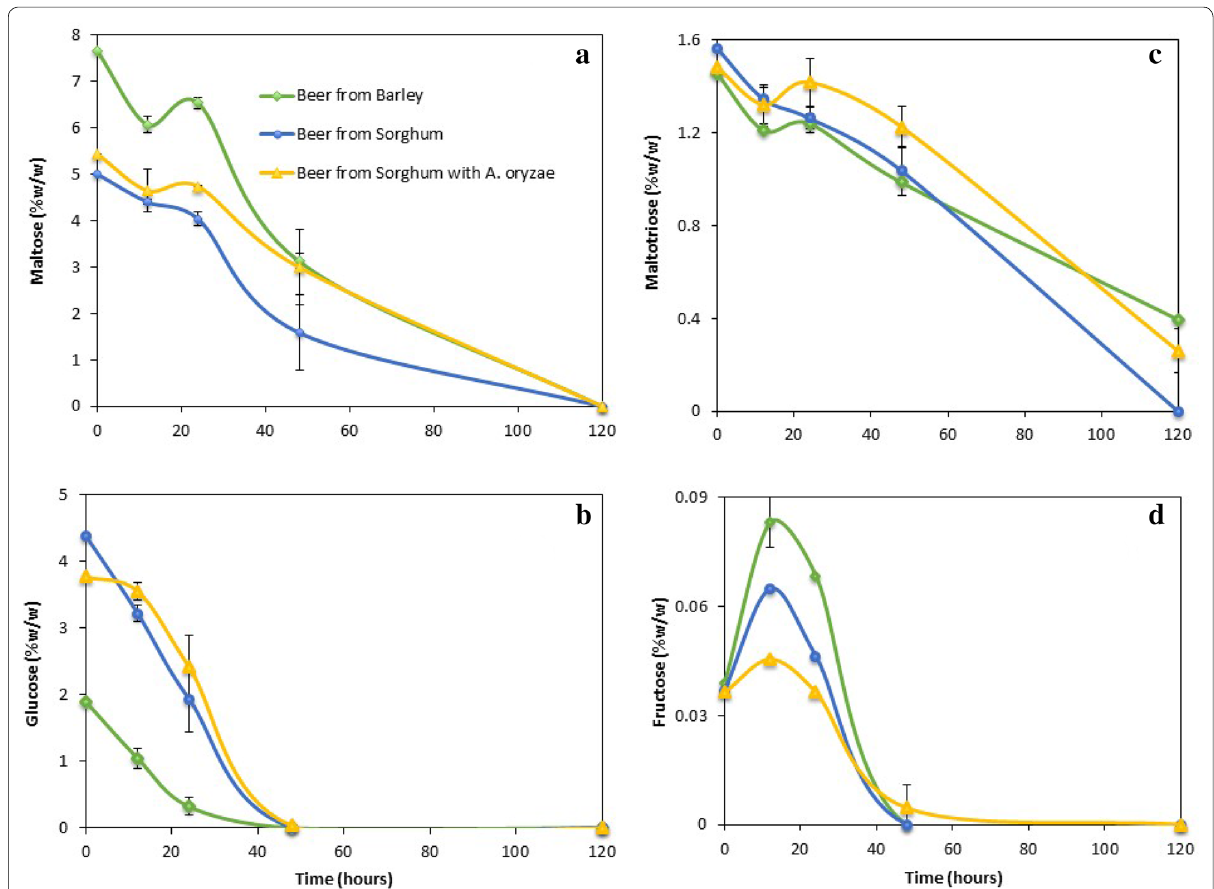
Fig. 2 Fermentable sugar depletion in worts from barley, sorghum or sorghum with A. oryzae fermented during 120 h. a Maltose (%); b glucose (%); c maltotriose (%); d fructose